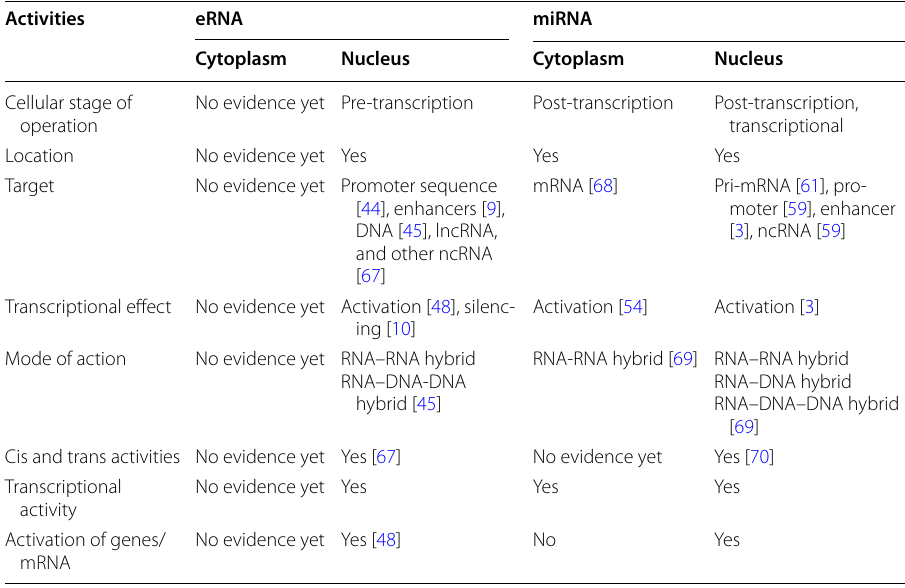
Table 1 Cellular activity similarities between eRNA and NamiRNA Activities eRNA miRNA Cytoplasm Nucleus Cytoplasm Cellular stage of No evidence yet Pre-transcription operation